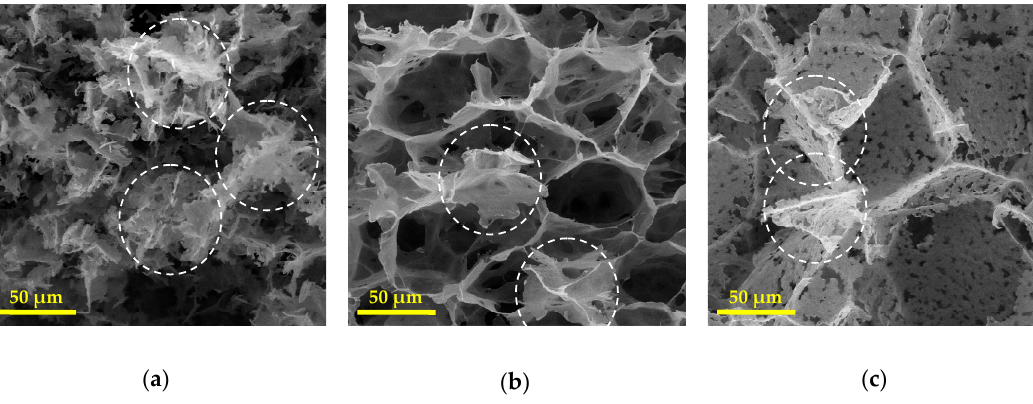
Figure 4. Scanning electron micrographs of cross-sections of PHBV scaffolds: ( a ) HBV5-R2, ( b ) HBV5-R6, ( c ) HBV12-R2. Dashed-line circles present areas detected as platelet-like structures.